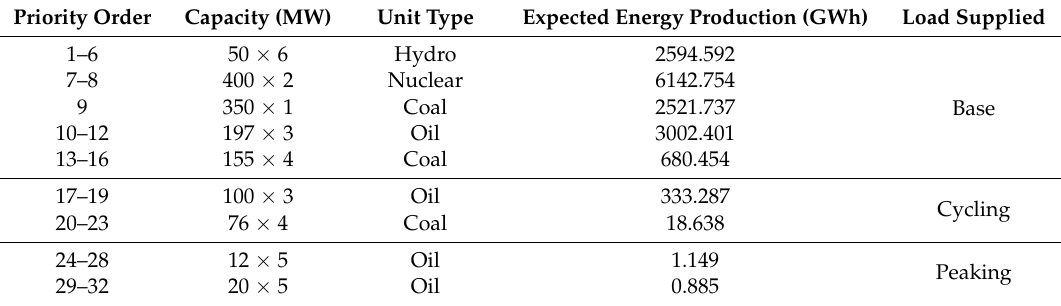
Table 3. The priority order and expected energy production of the IEEE-RTS generation system.